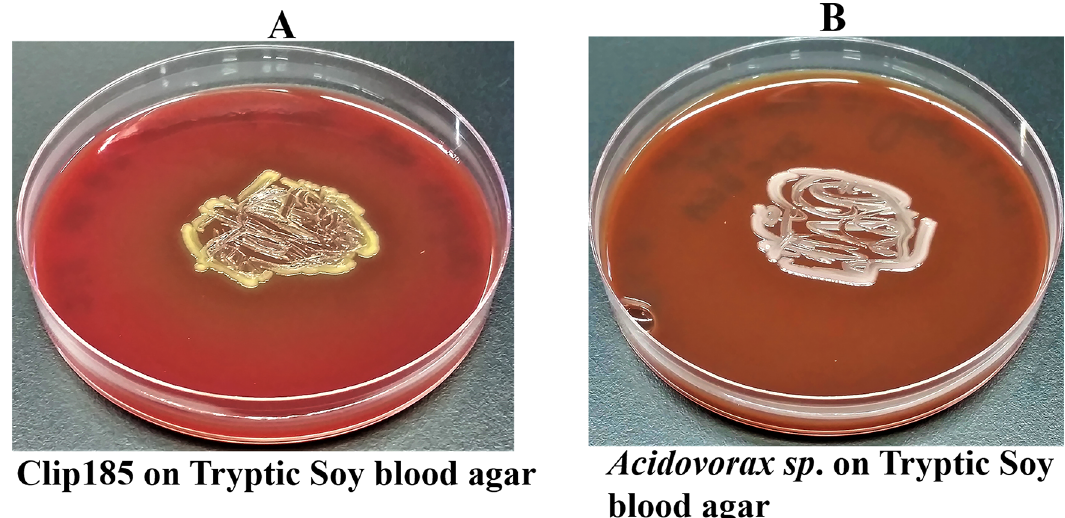
Figure 5. Clip185 is gamma hemolytic. (A) 72 hours-growth of Clip185 on tryptic soy-blood agar plate. (B) 72 hours- growth of a gamma-hemolytic Acidovorax sp. on tryptic soy-blood agar plate. Media plates were incubated at 37 °